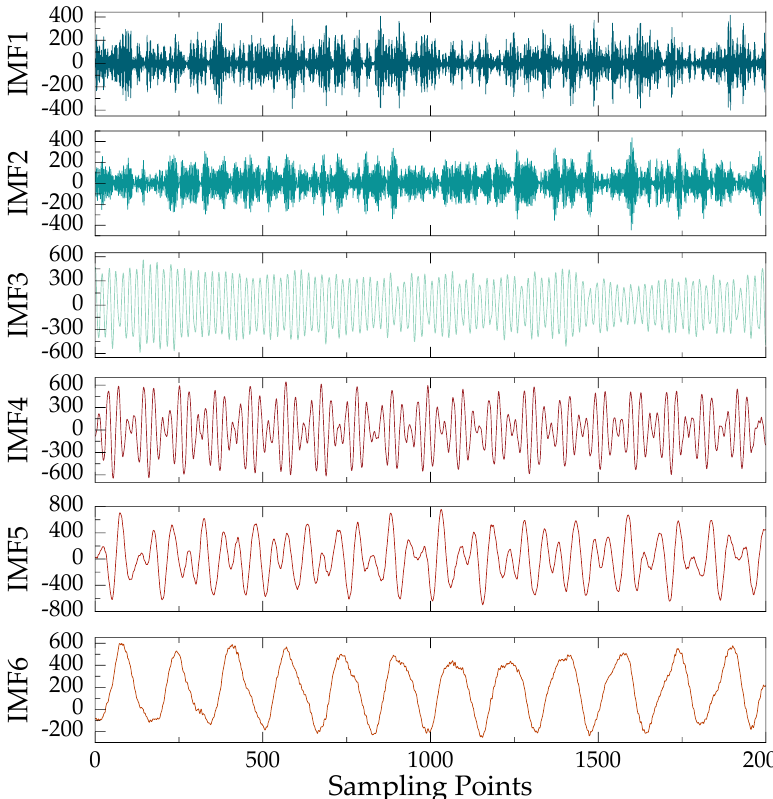
Figure 4. Vibration signal after superimposing random noise in normal condition.